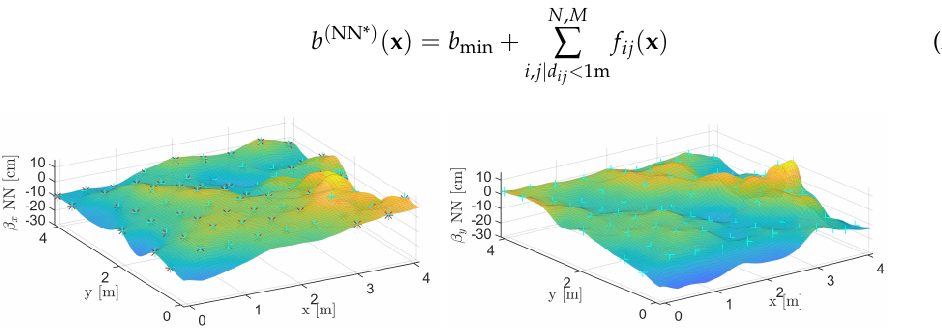
Figure A2. RBFN surface interpolating bias values of estimated position of the x ( left ) and y ( right )